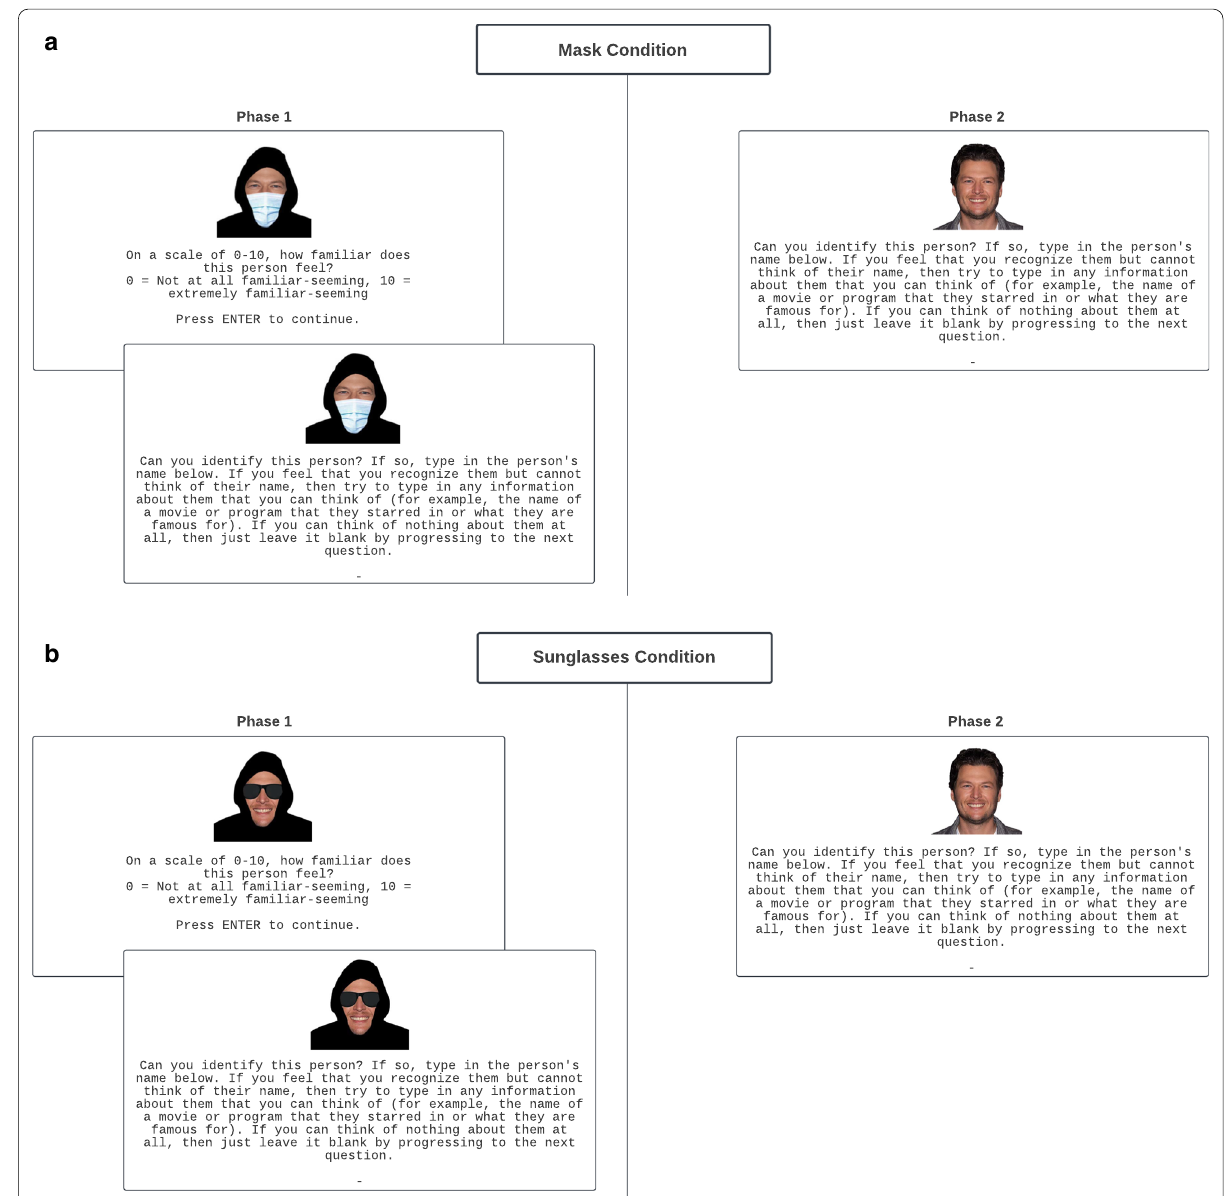
Fig. 2 a Example of the procedure for the surgical face mask condition. The celebrity face Blake Shelton is depicted along with the prompts shown during Phase 1 and then unmasked and unhooded in Phase 2. Original celebrity image from DFree/Shutterstock.com. b Example of the procedure for the sunglasses condition. The celebrity face Blake Shelton is depicted along with the prompts shown during Phase 1 and then unmasked and unhooded in Phase 2. Original celebrity image from DFree /